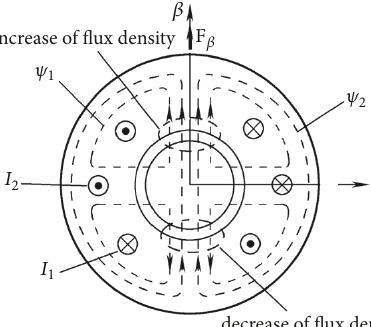
Figure 1: Schematic diagram of controllable magnetic suspension force